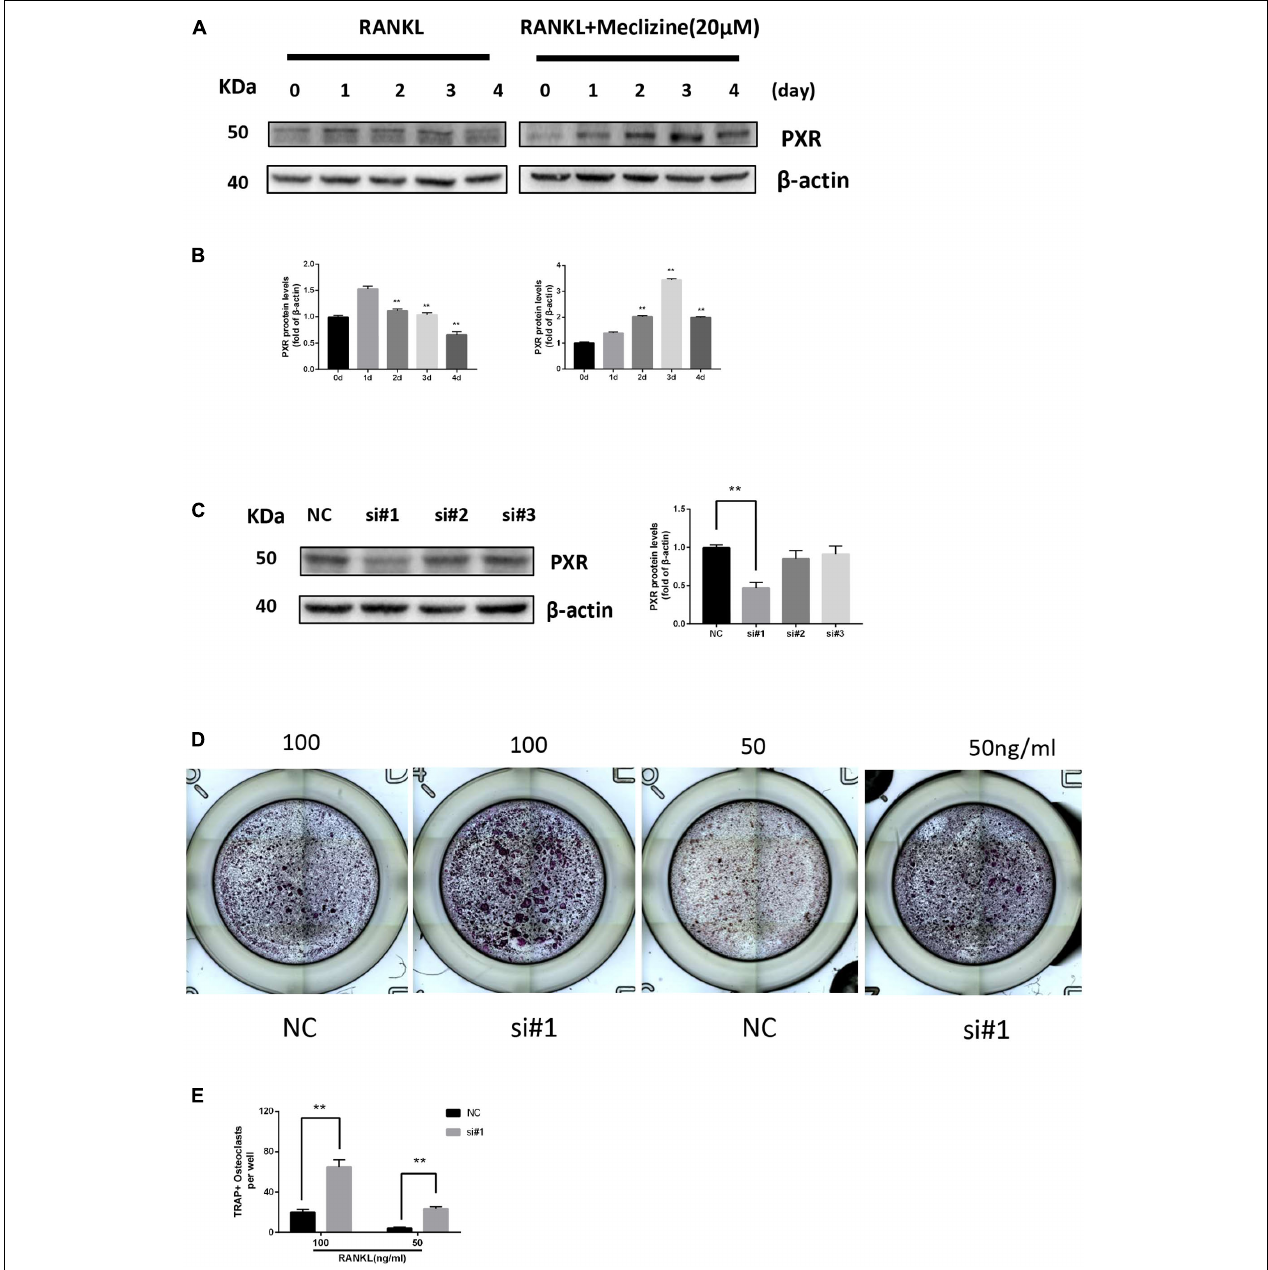
FIGURE 1 | Pregnane X receptor (PXR) is repressed during osteoclastogenesis and upregulated by meclizine. PXR knockdown increases osteoclast differentiation. (A,B) BMMs were seeded on day 0, and cultured in the presence of RANKL (100 ng/mL) and M-CSF (30 ng/mL) with or without meclizine. Cells were collected to analyze PXR protein expression and β -actin was used as a loading control. Data are presented as mean ± SD of 3 independent experiments. ∗∗ P < 0.01 versus 1 day group. (C) The expression of PXR in BMMs was evaluated by western blot analysis. Data are presented as mean ± SD of 3 independent experiments. ∗∗ P < 0.01. (D,E) BMMs (1.0 × 10 4 cells/well) were seeded in 96-well plates, transfected with PXR siRNA and cultured with M-CSF (30 ng/mL) and different concentrations of RANKL (50, 100 ng/mL) for 3 days. Subsequently, TRAP staining was performed, and TRAP-positive multinucleated cells ( ≥ 3 nuclei) were counted and photographed by a microscope. Data are presented as mean ± SD of 3 independent experiments. ∗∗ P <